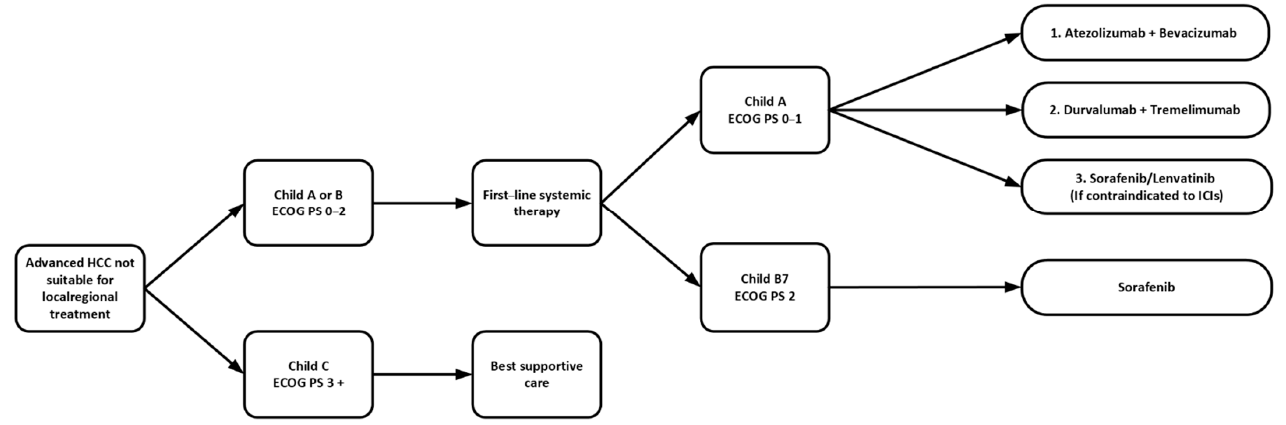
Figure 1. Sequence of first-line systemic therapy in advanced HCC. ECOG PS: Eastern Cooperative Oncology Group Performance Status; ICIs: immune checkpoint inhibitors; HCC: hepatocellular carcinoma.